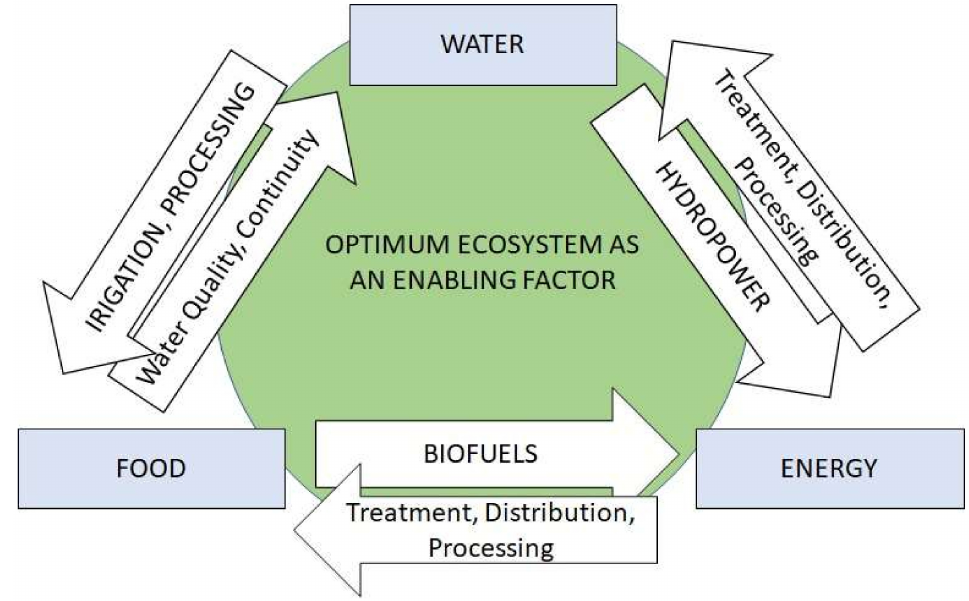
Figure 1. Interlinkages of WEF and Ecosystem (modified from